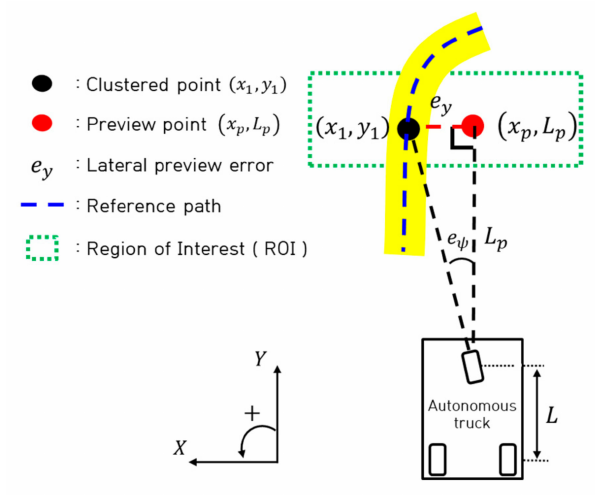
Figure 4. Path error derivation.